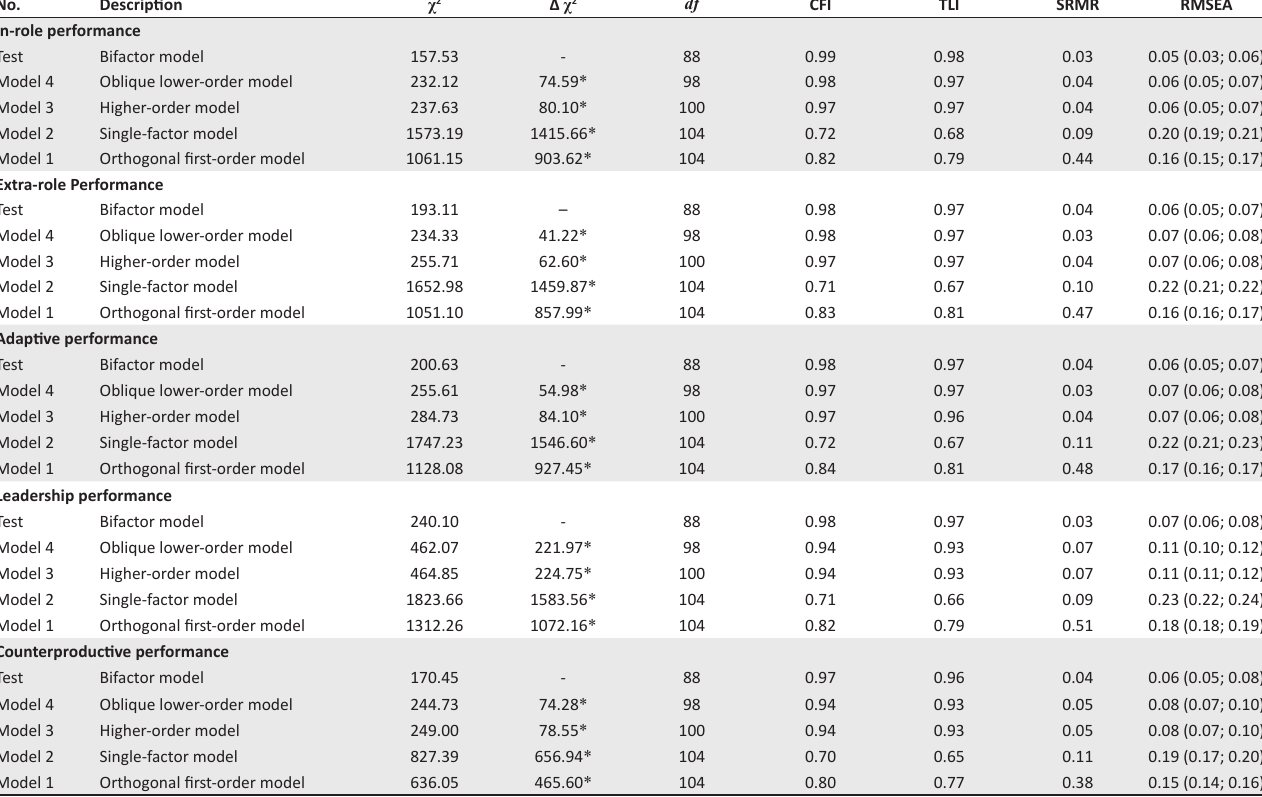
TABLE 2: Fit statistics of different performance factor models.